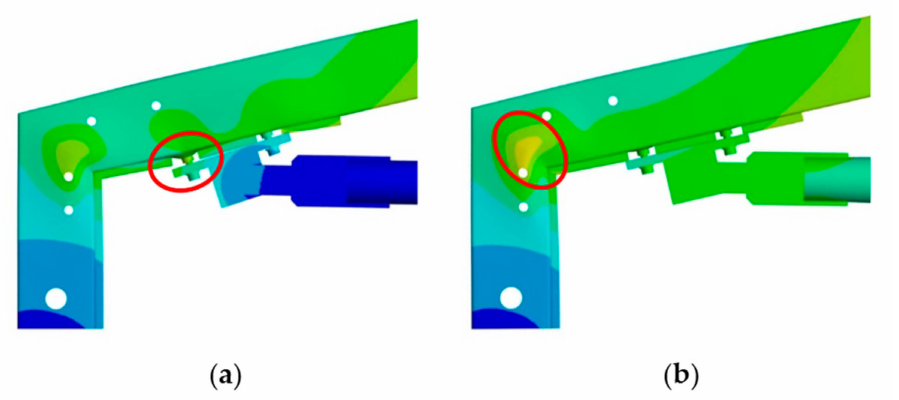
Figure 17. Comparison of failure modes for different tie element stiffnesses: ( a ) E’ = 210,000 MPa; ( b ) E’ = 610